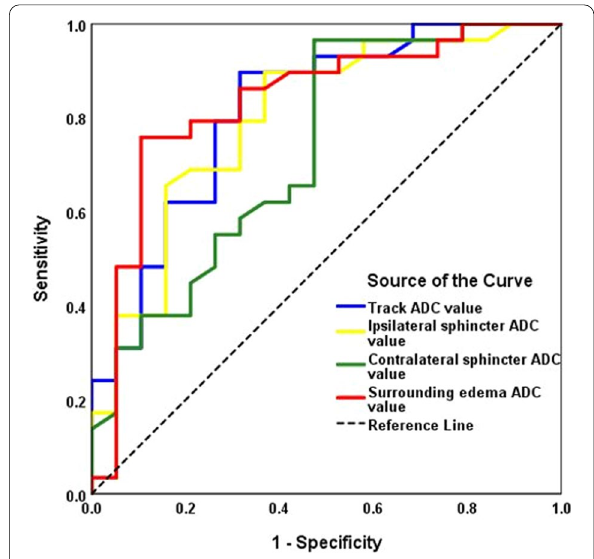
Fig. 5 ROC curve analysis for ADC measures to differentiate active conditions